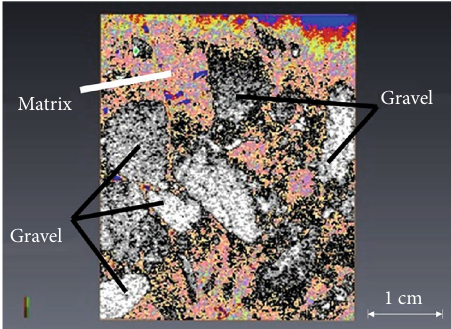
Figure 6: Results of threshold division. Color rendering is performed on di ff erent density areas. The white light areas are identi fi ed as gravel, and the other stained areas are rock matrixes, which include low-density clay minerals and some high-density rock debris.